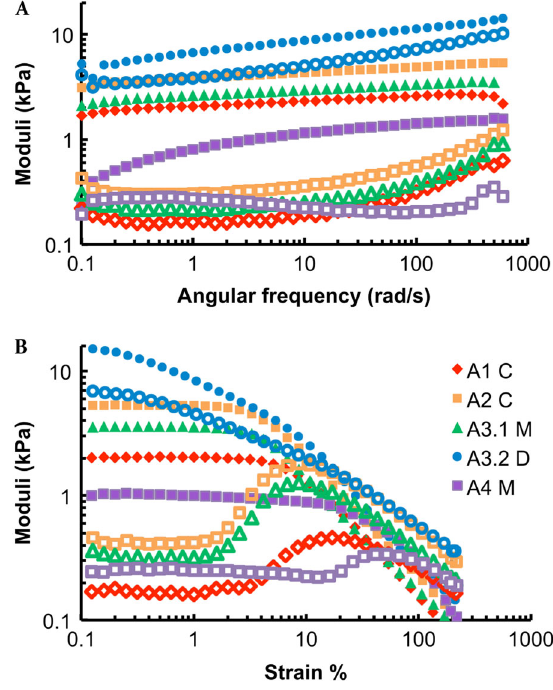
Fig. 1 ( a ) Frequency and ( b ) strain sweeps for 1 day ’ s worth of measurements on bio fi lms grown from the fi ve infecting strains isolated from Patient A at different points in time. Frequency sweeps were done at 1 % strain and strain sweeps were done at 3.14 radians/s. The elastic moduli ( G ′ ) are shown with solid symbols and the viscous moduli ( G ′′ ) are shown with hollow symbols of corresponding shape and color. Strains are listed in order of isolation — see Table S1 for timepoints of isolation. Isolates from later timepoints tend to have higher elastic moduli, except for the two mucoid isolates, A3.1 M and A4 M, which have high